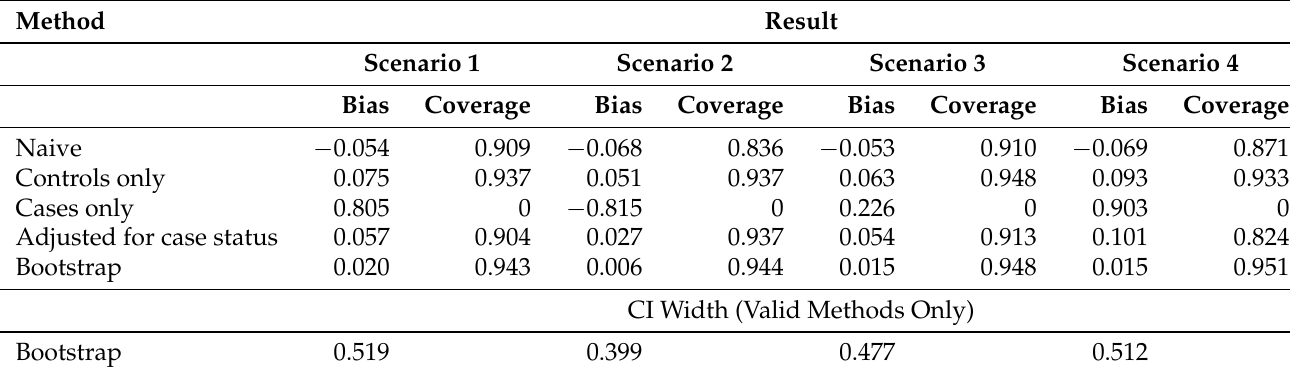
Table 2. Results of simulations for intermediate ordinal phenotypes.